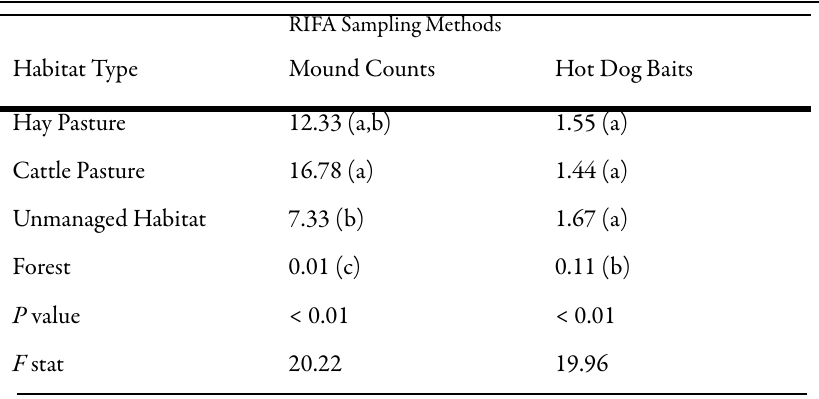
Table 1. Mean number of active RIFA mounds and hot dog bait ‘hits’ from within plots in each habitat